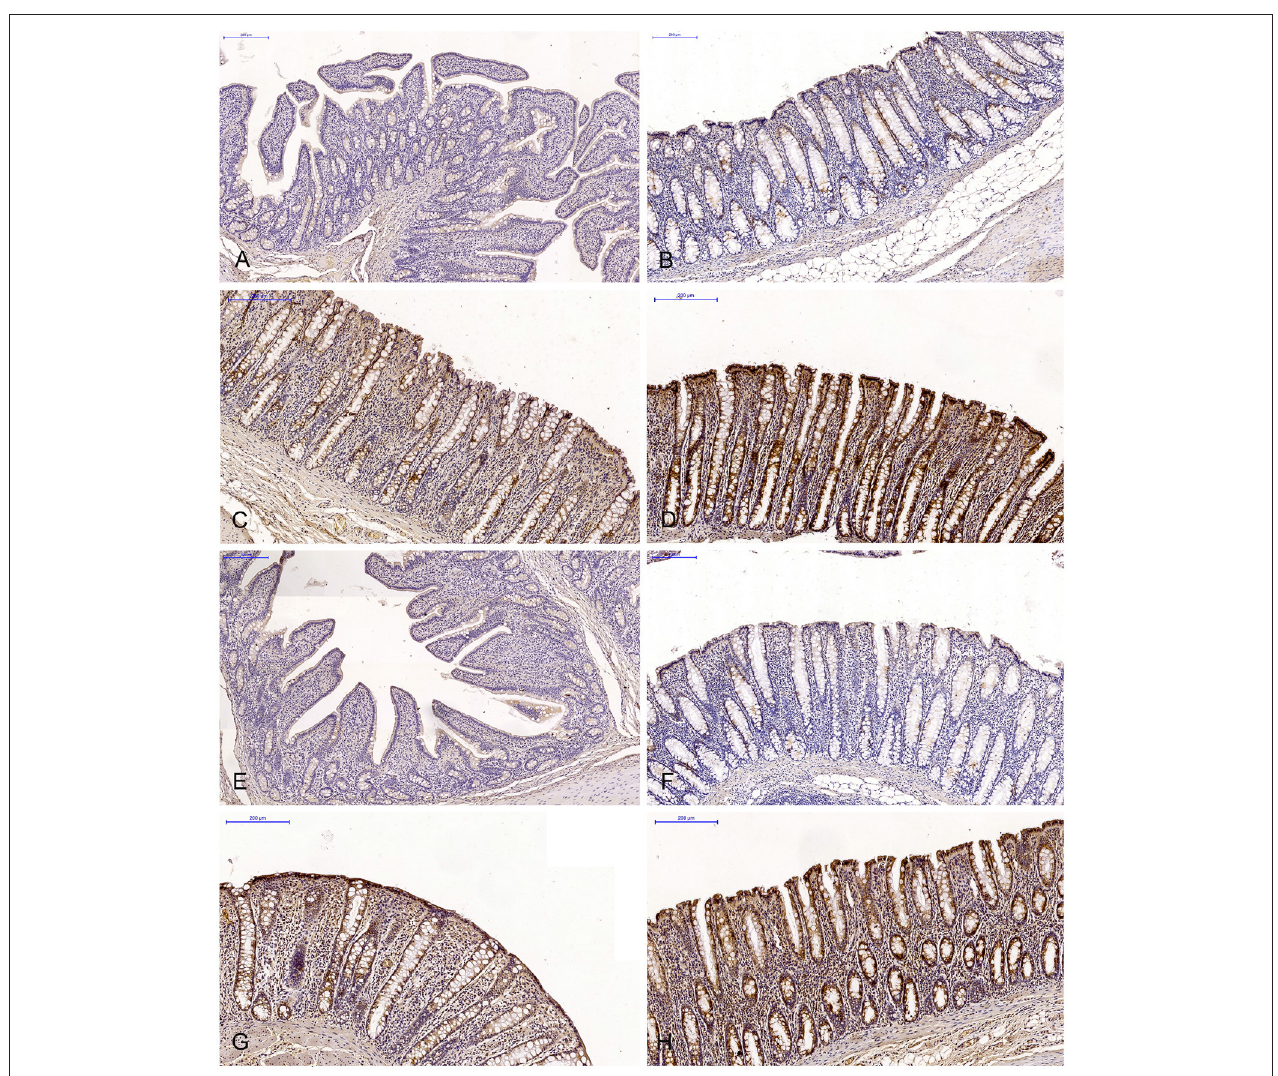
FIGURE 1 | Scanned slides of immunohistochemical expression of ER α receptors in the descending colon in group C [ (A) 0; (B) + ; (C) ++ ; (D) + + + ] and group E [ (E) 0; (F) + ; (G) ++ ; (H) + + + ]. HE.